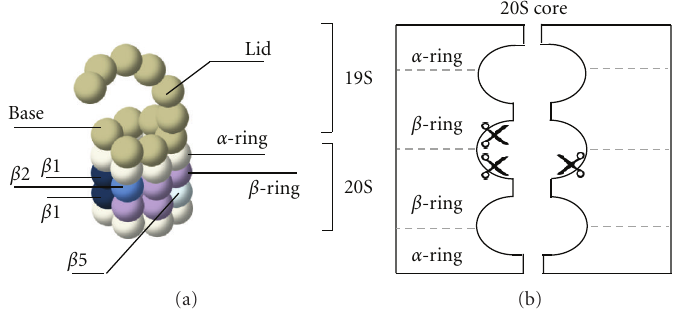
Figure 1: Representation of the 26S proteasome. (a) The 26S proteasome consists of a 20S core capped by one or two 19S activators. The catalytic subunits β 1, β 2 and β 5 are represented in blue in the β -ring. (b) A schematic model of the 20S core, indicating the presence of cleavage sites inside the barrel-shaped